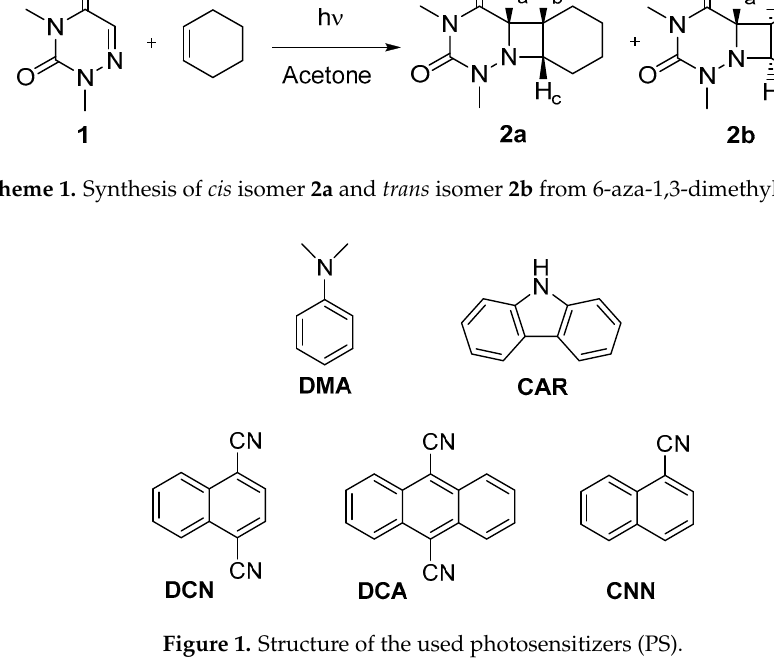
Figure 1. Structure of the used photosensitizers (PS).